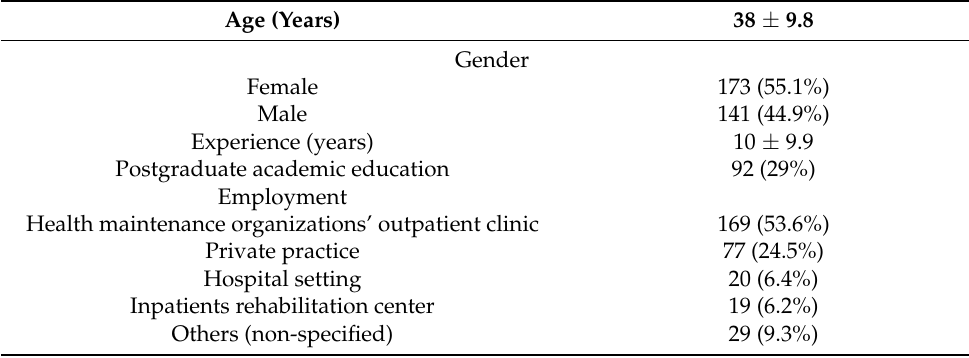
Table 1. Demographics of the survey respondents (first survey completion, N =